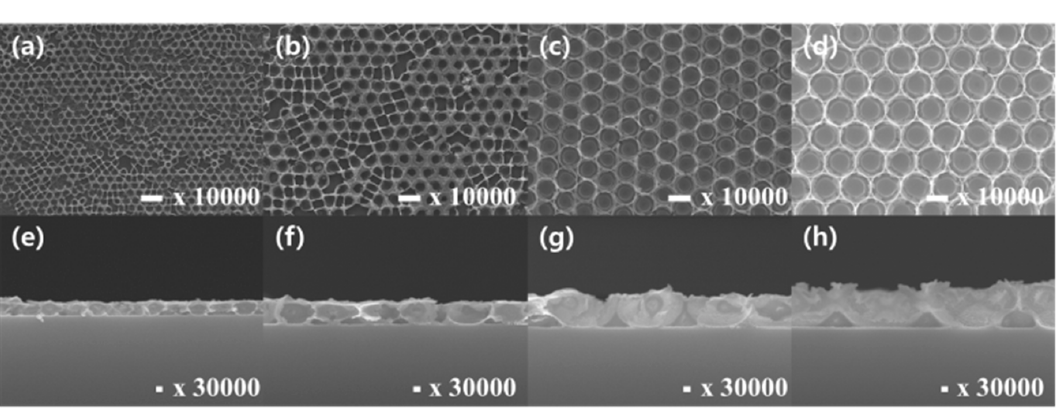
Figure 3. XRD pattern of the 400 nm size PS-patterned TiO 2 film. X-ray photoelectron spectroscopy (XPS) measurements were made in order to observe the chemical state changes of PS-patterned TiO 2 thin films during the manufacturing process. In Figure 4, Ti 2p 1/2 was observed at ~463 eV, and Ti 2p 3/2 was observed at ~458 eV. For the PS-patterned TiO 2 thin films (400, 700, 1000, and 1300 nm), a chemical shift also occurred. However, it appears there was no distinct order and no binding energy difference for all samples [24]. Accordingly, there was no difference due to the defects of TiO 2 inducing by oxygen vacancy when making the films. Therefore, we concluded that all PS-patterned TiO 2 thin films were observed only for the Ti 4+ chemical state. In particular, only small changes in relative intensity (400 > 700 > 1000 > 1300 nm) of the TiO 2 films with PS patterns were observed. This means that the intensity of XPS spectra changes very little; therefore, it is suggested that as the PS size decreases, the amount of the TiO 2 increases and the intensity of the XPS spectrum increases when decreasing the PS sizes. In other word, the same sequence such as the relative intensity (400 > 700 > 1000 > 1300 nm) of PS-patterned TiO 2 thin films was obtained because of the same mean free path of the electron in the TiO 2 film layers under the same energy ranges of X- ray photoelectrons, even though the samples have different thickness. These results would be closely related with the values of the surface area.